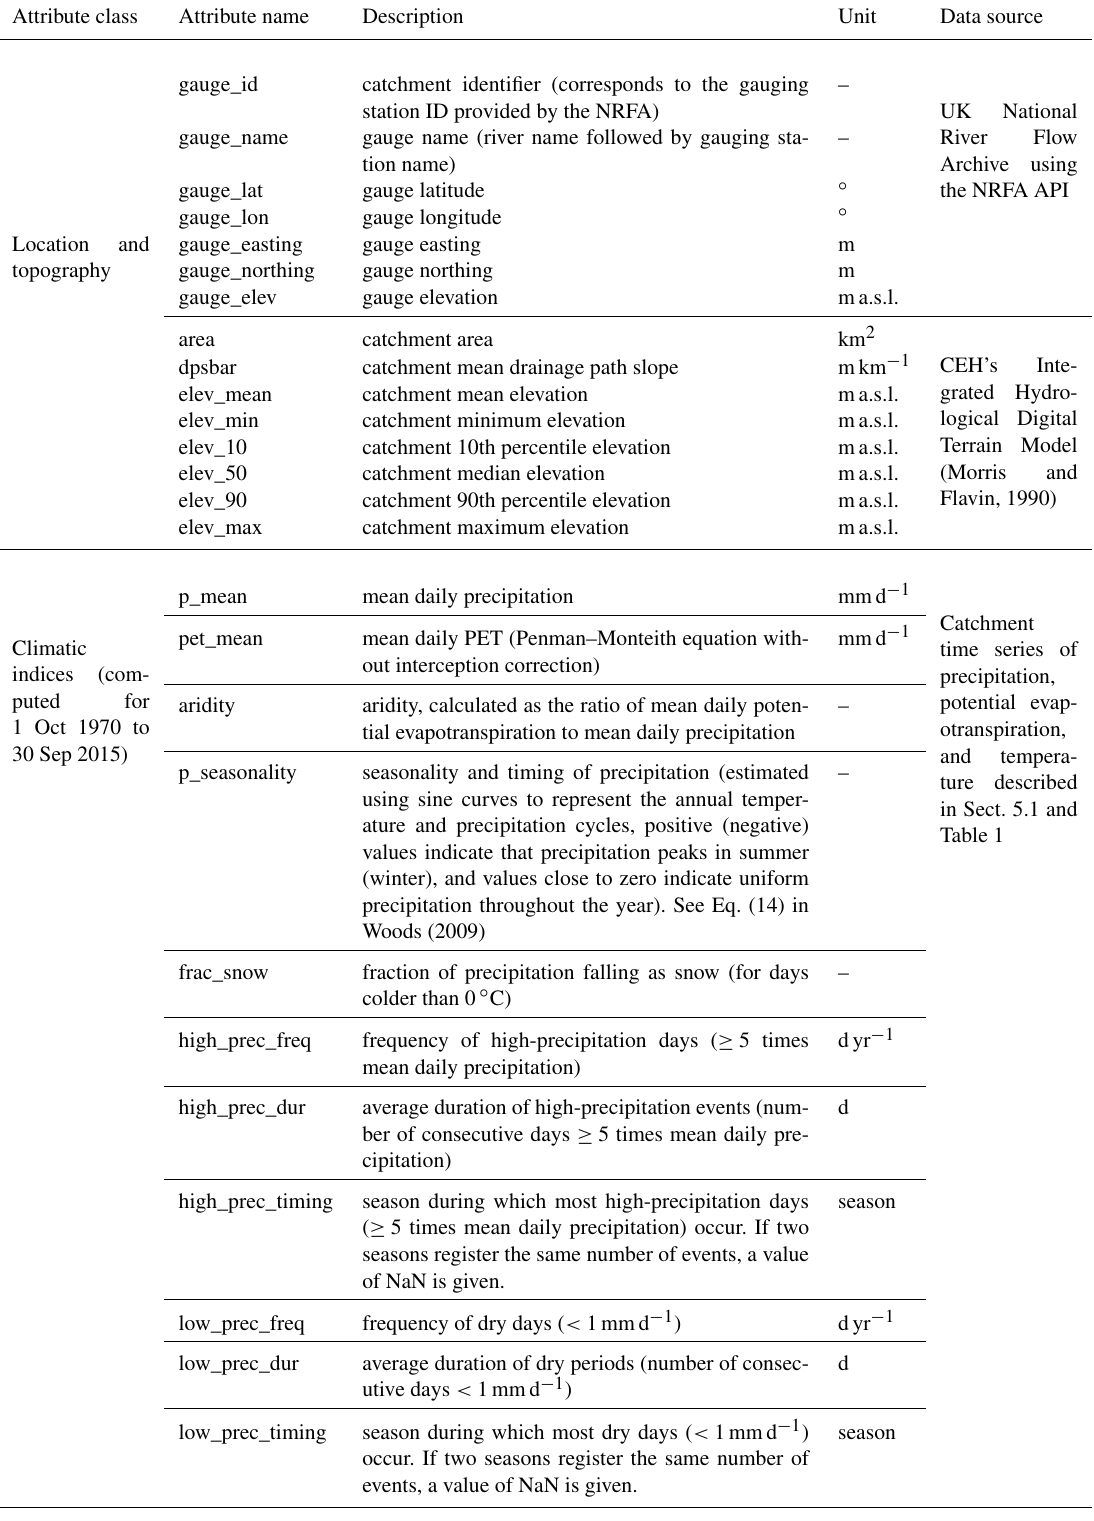
Table 2. Summary table of catchment attributes available in